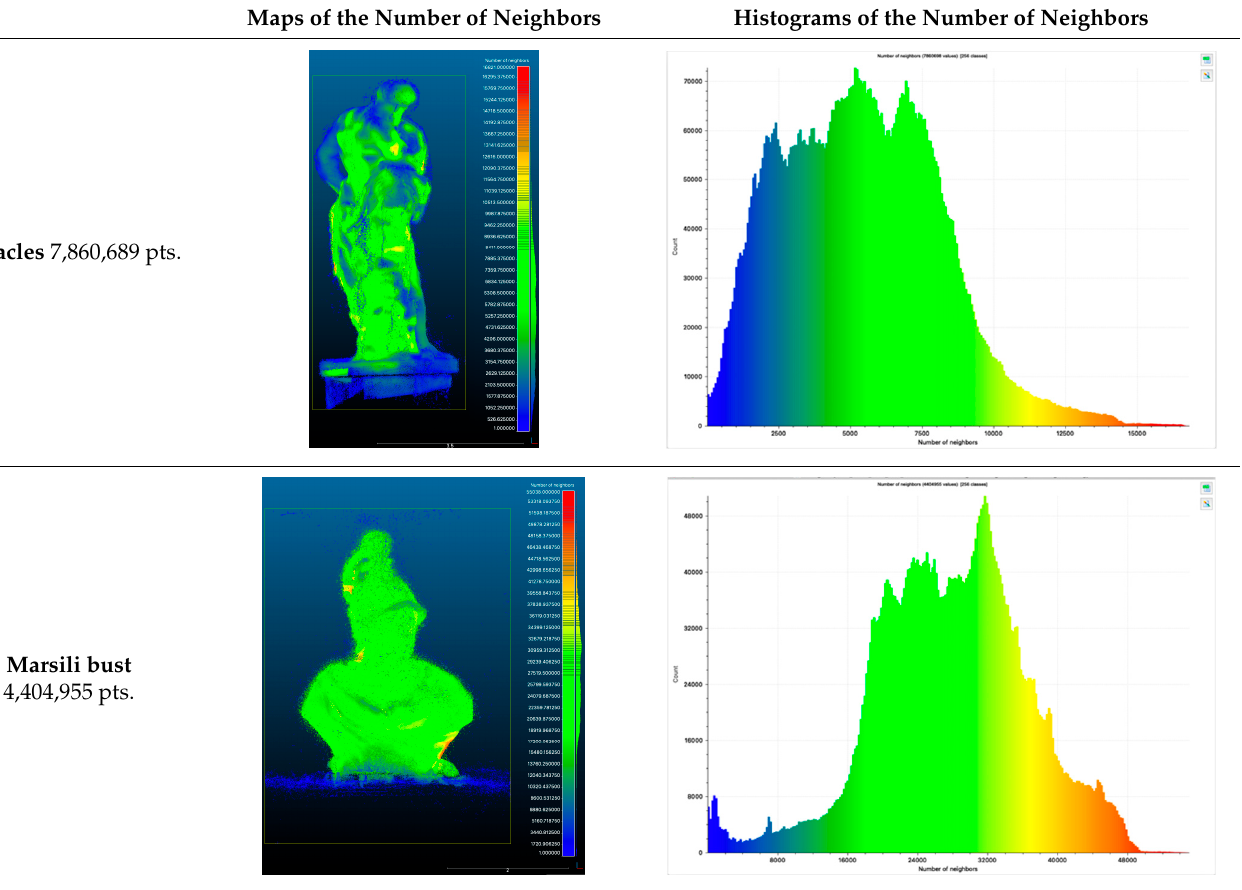
Table 11. Local Density Computation (LDC) computation (radius: 2 cm) on dense matching of the four datasets acquired using iPhone X. The color-code maps show the matched point distribution. Maps of the Number of Neighbors